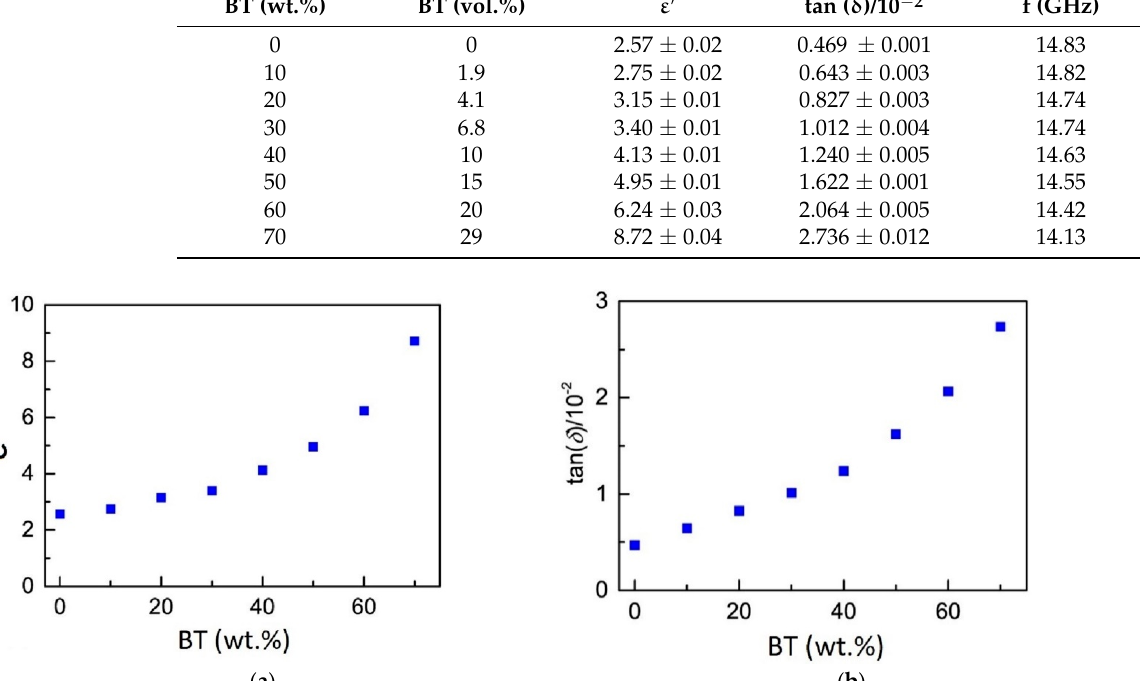
Figure 3. ( a ) Values of the permittivity ε′ of 3D printed parts for various loading fractions of BT in ABS; ( b ) Values of the loss tangent of 3D printed parts for various loading fractions of BT in ABS (available under Creative Commons license [58]).